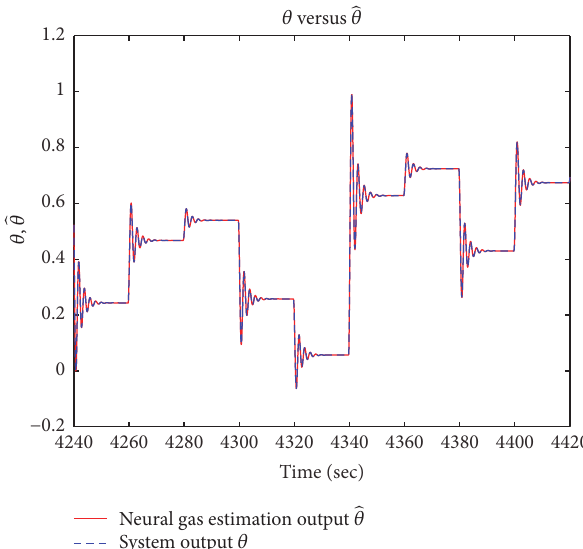
Figure 4: Results for testing data using 𝑛 = 4 .